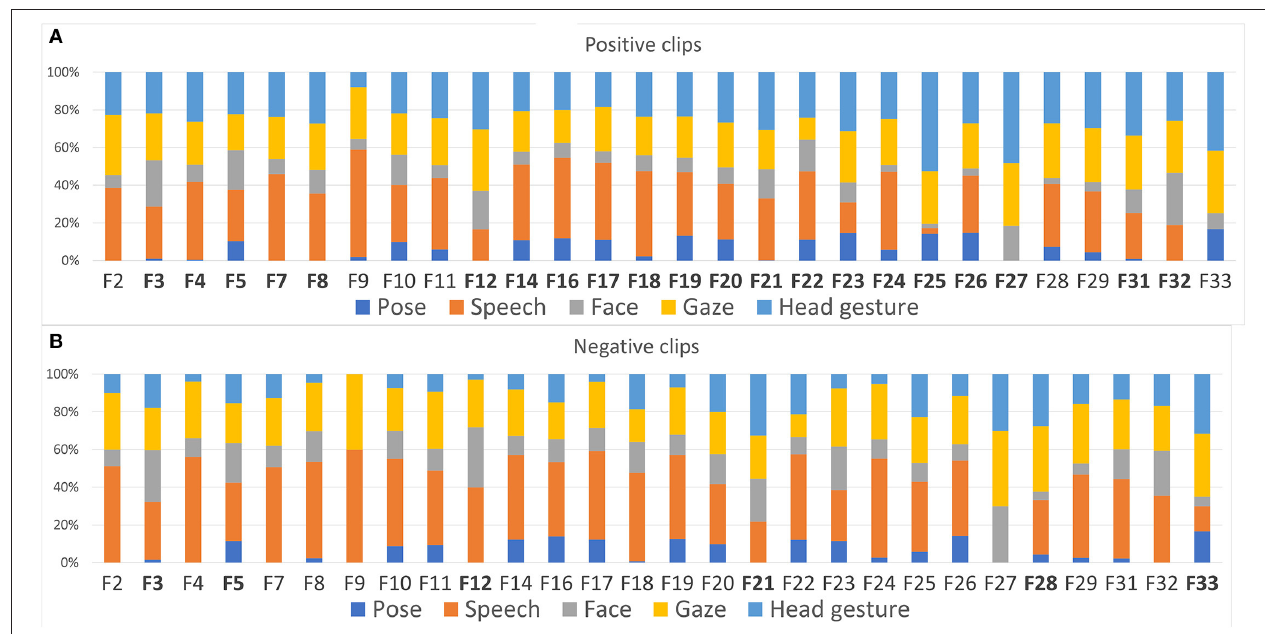
FIGURE 3 | The usage of different modalities of feedback from different individuals in our dataset. (A) Only when considering clips labelled as positive by the crowdworkers. (B) Only considering clips labelled as negative . In both graphs, distributions that are significantly different from the mean according to a χ 2 test are marked by bolding the identifier of the participant, see section